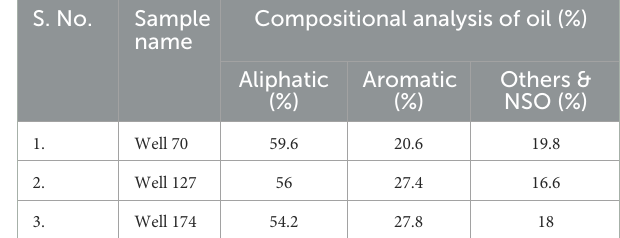
TABLE 1 Physicochemical characterization of formation water collected from Bhagyam fields.